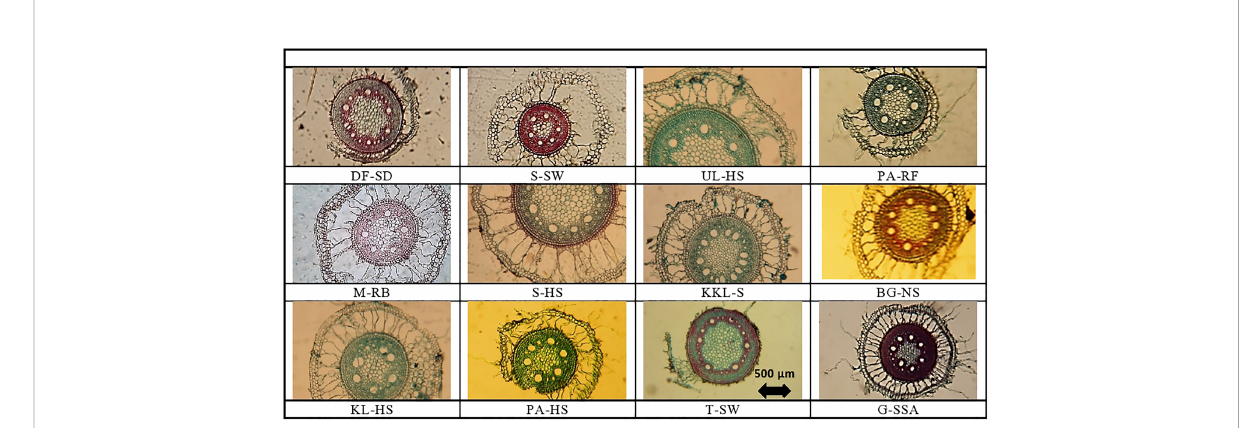
FIGURE 2 Root tranverse sections of Cynodon dactylon ecotypes collected from the Punjab, Pakistan DF-SD, Derawar Fort-Hyper Desert; M-RB, Muzaffar Garh-River Bank; KL-HS, Khabbeki Lake-Hyper Salin; UL-HS,Ucchali Lake-Hyper Saline; KKL-S; Kalar Kahar Lake-Saline; T-SW, Treemu-Saline Wetland; S-SW, Sahianwala-Saline Wetland; Sahianwala-Hyper Saline; PA-HS, Pakka Anna-Hyper Saline; PA-RF, Pakka Anna-Reclaimed Field; BG-NS, Botanic Gardine-None Saline; G-SS, Gatwala-Saline Semiarid.